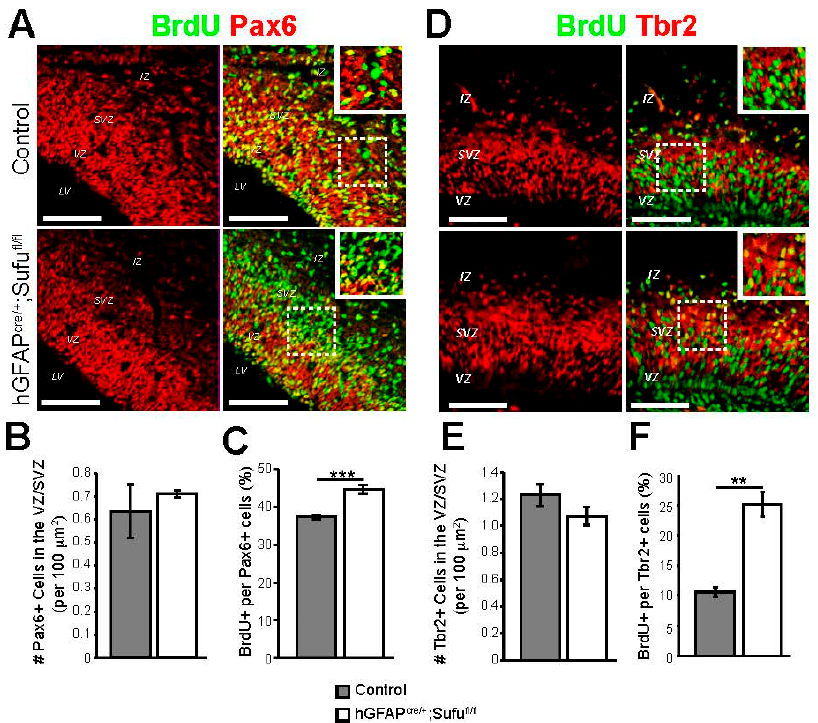
Figure 4. Loss of Sufu led to expansion of Pax6+ and Tbr2+ basally dividing cells. ( A – C ) Pax6 and BrdU double immunostaining ( A ) did not show obvious differences in the density of Pax6+ RG cells in the VZ/SVZ between control and hGFAP cre/+ ;Sufu fl/fl mice at E16.5 and verified by quantification ( B ); On the other hand, BrdU-labeled Pax6+ cells were visibly obvious (boxed insets, A ) and significantly increased in the E16.5 hGFAP cre/+ ;Sufu fl/fl neocortex compared to controls ( C ); ( D – F ) Tbr2 and BrdU double immunostaining ( D ) did not show obvious differences in the density of Tbr2+ IP cells in the VZ/SVZ between control and hGFAP cre/+ ;Sufu fl/fl mice at E16.5. This was verified by quantification of Tbr2+ cell density ( E ); However, a greater number of BrdU-labeled Tbr2+ cells was observed within the VZ/SVZ of hGFAP cre/+ ;Sufu fl/fl mice at E16.5 (boxed inset, D ); Quantification of double-labeled IP cells was measured and yielded a significantly higher percentage of BrdU-labeled Tbr2+ cells in the E16.5 hGFAP cre/+ ;Sufu fl/fl VZ/SVZ compared to control littermates ( F ); ** p -value < 0.03; *** p -value < 0.01. Scale bars = 200 µ m; LV, lateral ventricle.